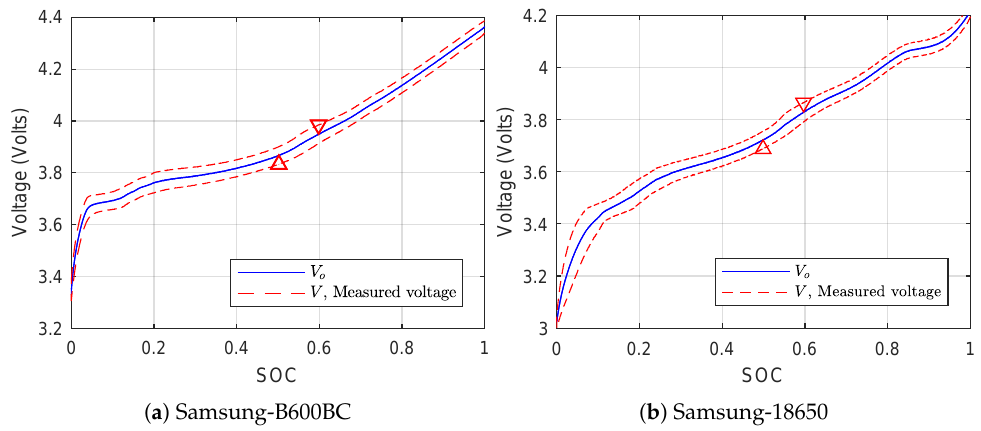
Figure 4. Battery voltage profiles for charging–discharging